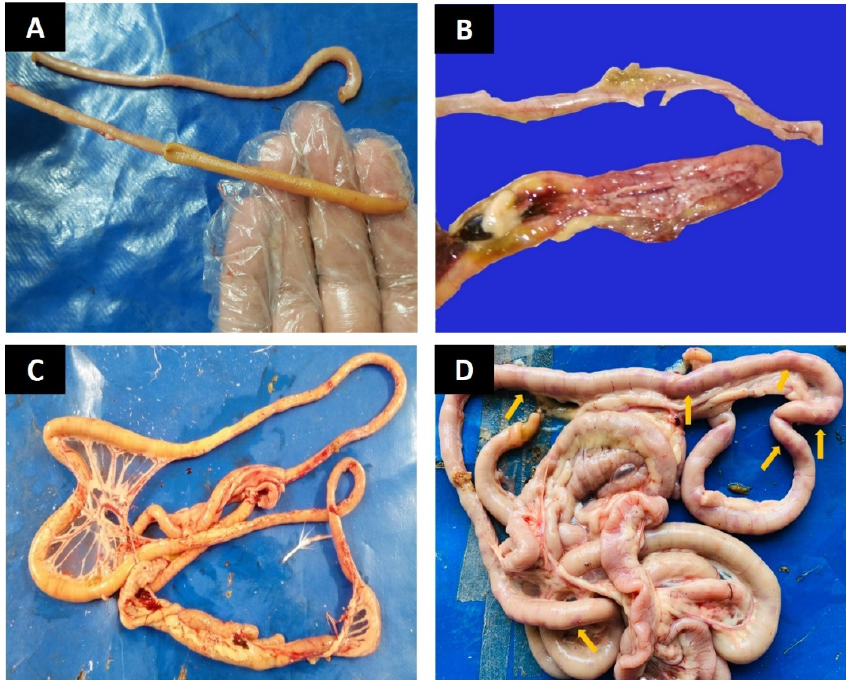
Figure 2. Photographs showing gross lesions of intestines ( A ) Normal appearance of intestinal mucosa and absence of any lesion in group A ( B ) Jejunum showing hemorrhages and perforations in the mucosa of group B ( C ) Moderate mucosal damage and congestion in intestine of group D ( D ) Jejunum showing areas of small hemorrhages visible from outside (arrows) in group